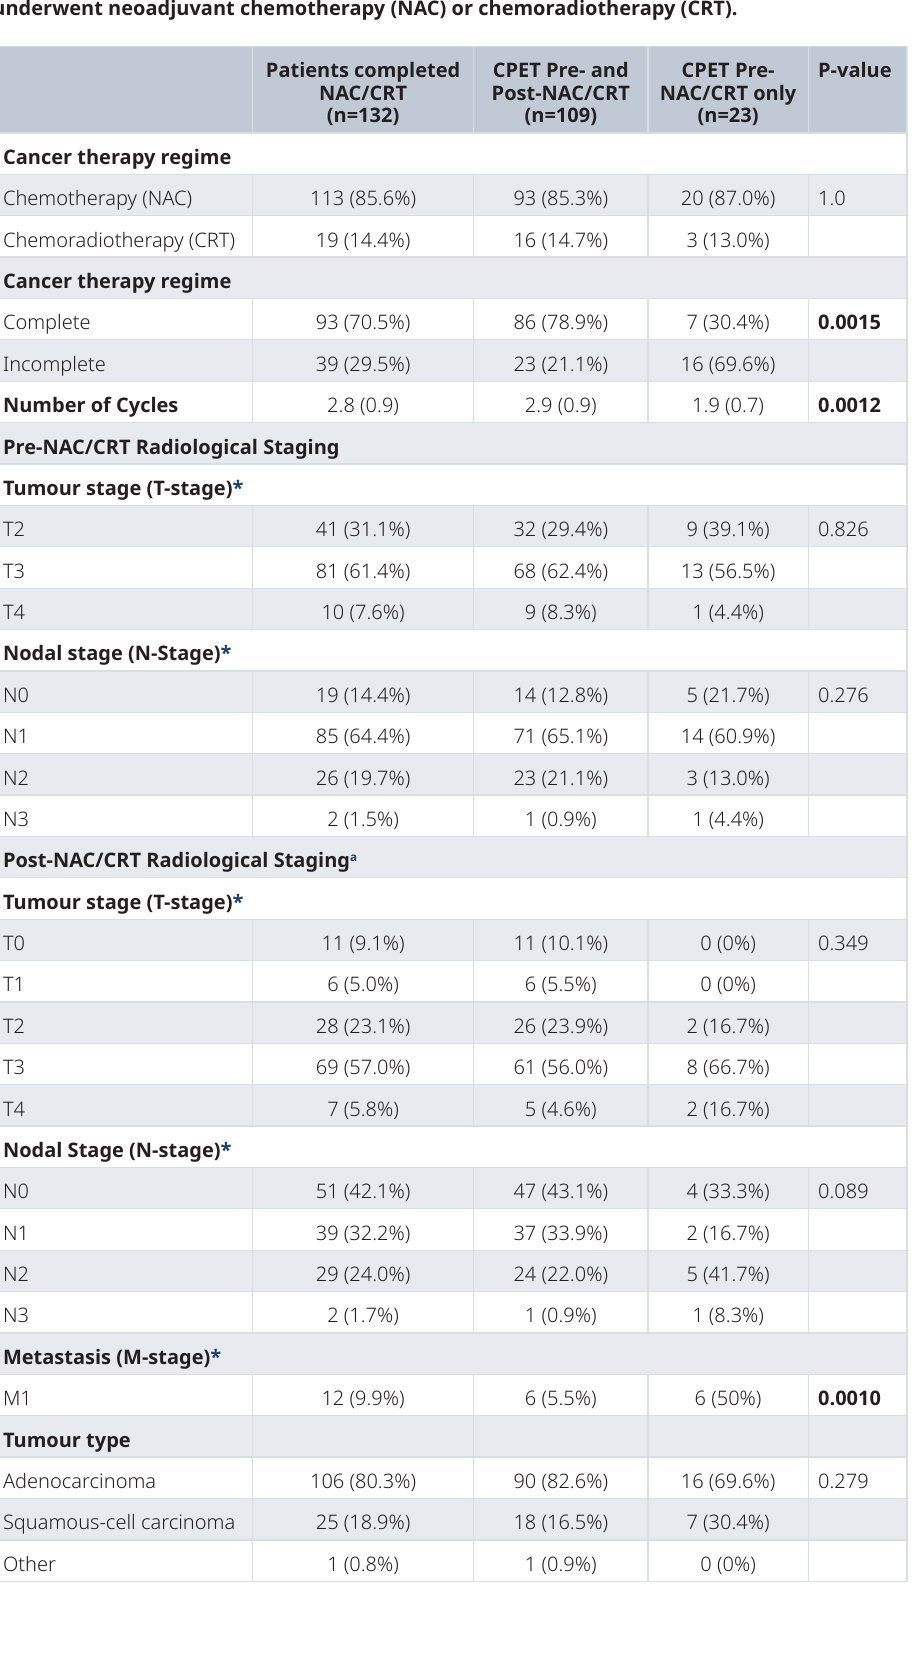
Table 2. Cancer regime, tumour characteristics and radiological responses of patients who underwent neoadjuvant chemotherapy (NAC) or chemoradiotherapy